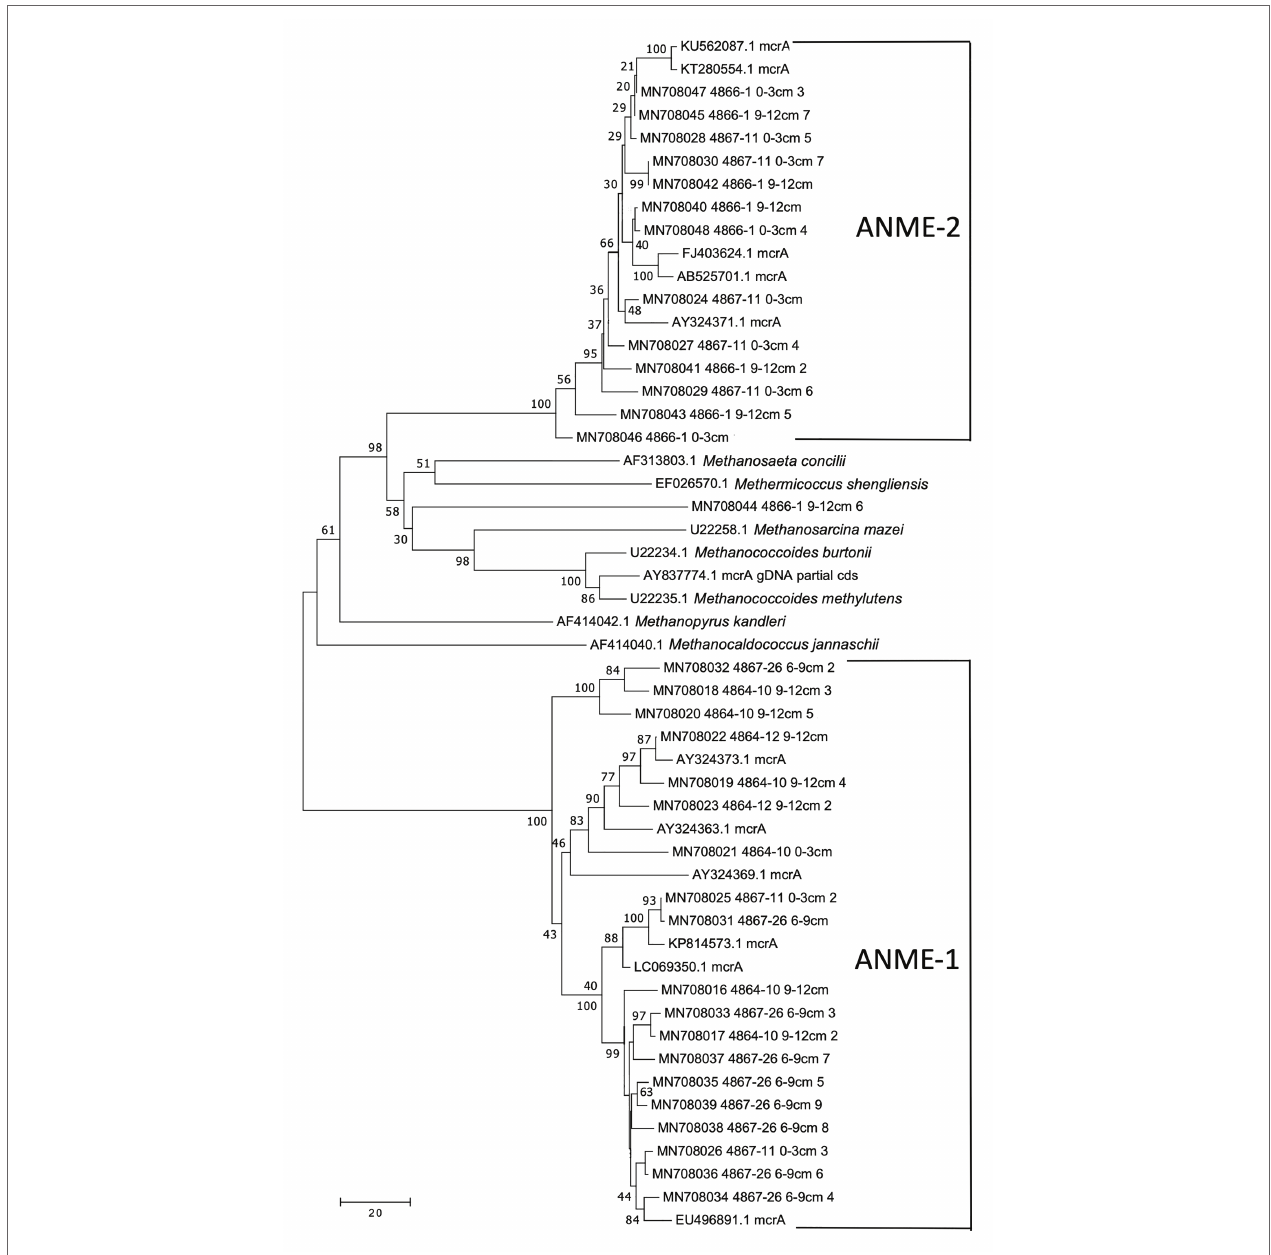
FIGURE 11 | Distance phylogeny of mcrA genes recovered from Octopus Mound sediments. Taxon labels begin with the Genbank number, followed by the Alvin Dive and core number, and (if applicable) the number of multiple clones from the same location and core that is represented by this sequence. Additional mcrA genes come from Ringvent sediments sampled during Alvin dive 4864 (Teske et al., 2019). Bootstrap numbers were obtained by 500